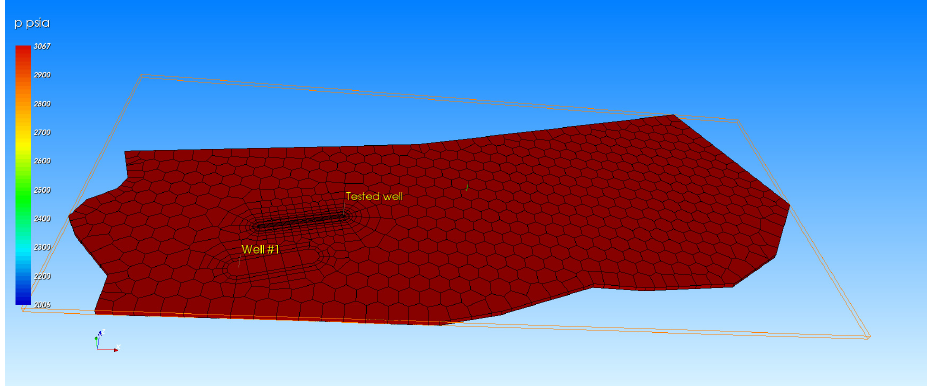
Figure 21. Numerical well test grid of 8 ‐ 5H well. Tested well represents 9 ‐ 1H well and Well #1 represents 8 ‐ 5H well. Lines and arrows. The lines form a grid, and the arrows represent directions.